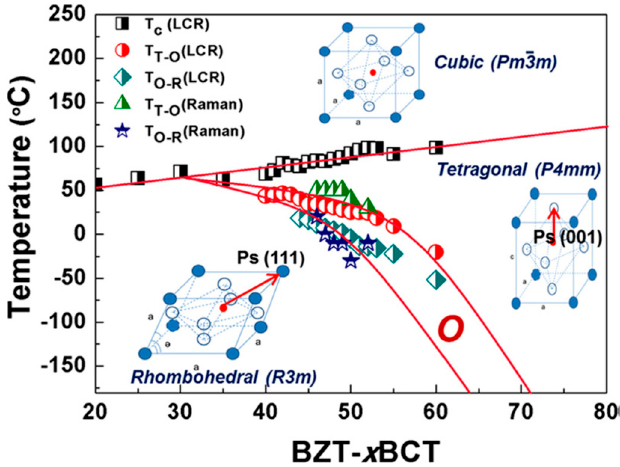
Figure 11. New phase diagram for BZT–BCT based on the crystal structure studies [72].